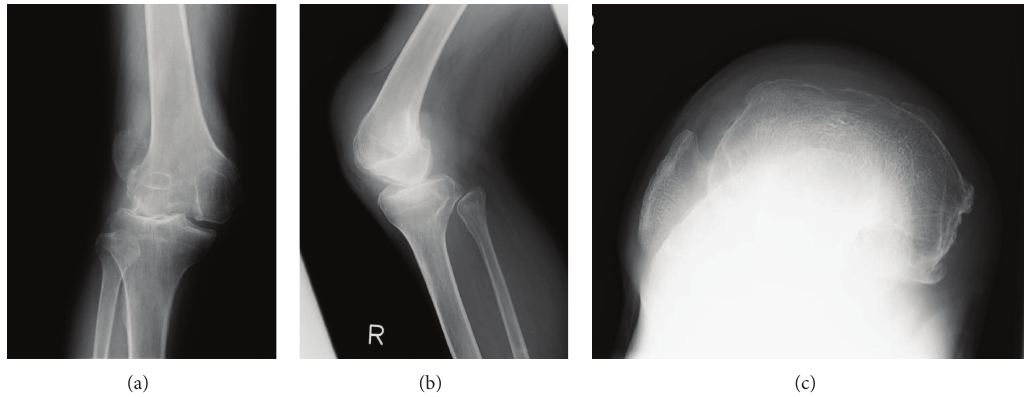
Figure 2: Preoperative radiographs: anteroposterior view (a), lateral view (b), and skyline view (c) of right